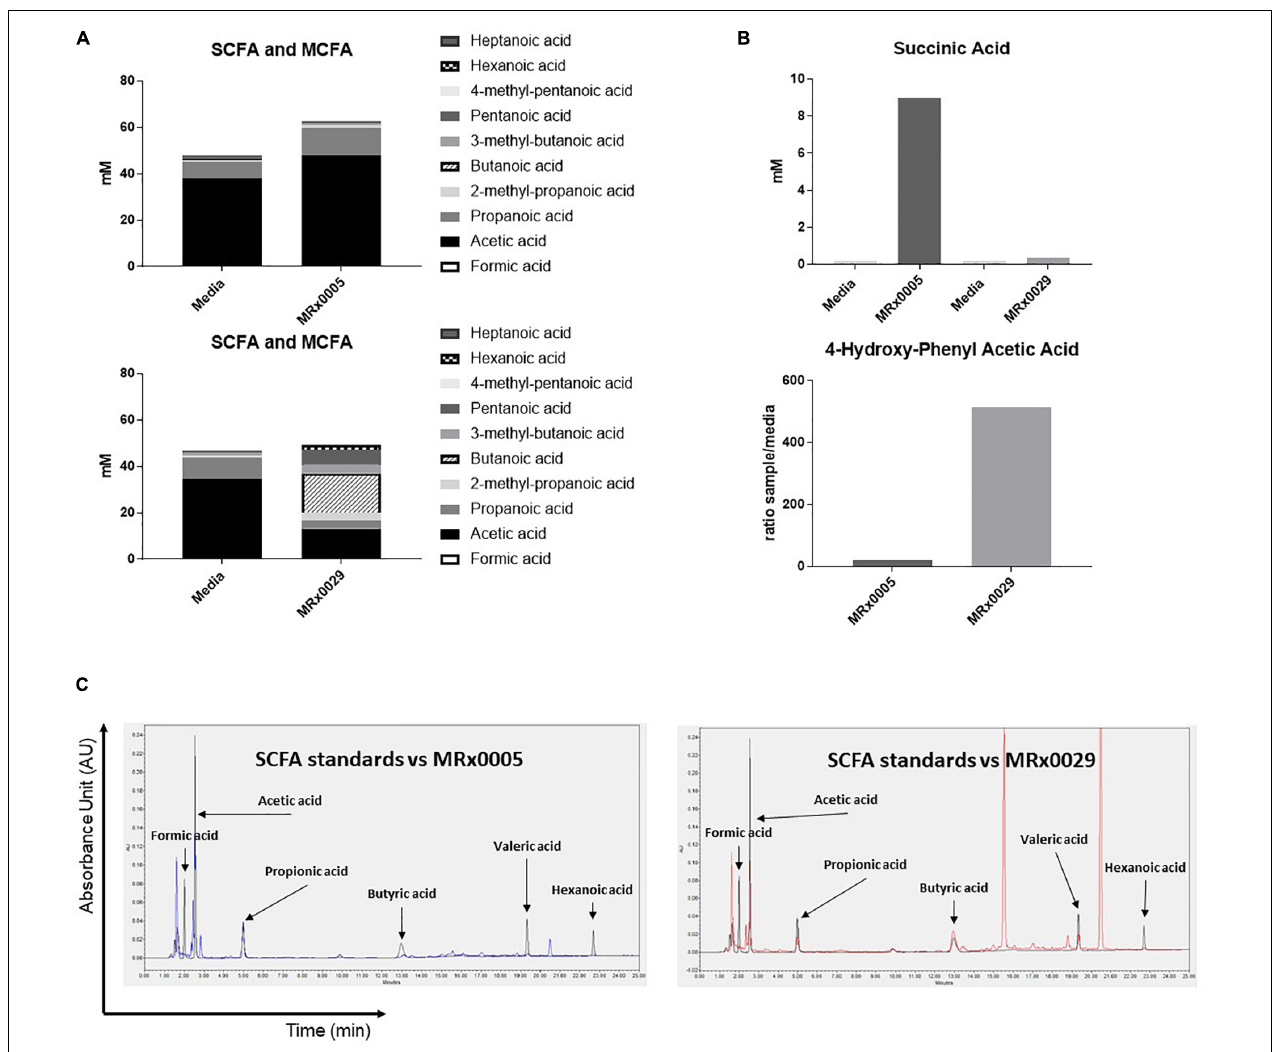
FIGURE 4 | Difference in metabolites produced by MRx0005 and MRx0029. Bacteria were grown to stationary phase and processed as described in section “Materials and Methods.” YCFA + was processed alongside MRx0005 and MRx0029. Authentic chemical standards were compared to retention time and mass spectra for the identified metabolites and/or based on library matching of the acquired MS spectra with the NIST library. Only metabolites that differed between the two strains are reported in this figure. (A) SCFA and MCFA profile (mM). (B) Succinic acid (mM) and 4-hydroxy-phenyl acetic acid (ratio sample/media). The data presented in (A,B) are from one experiment ( n = 1). (C) Representative chromatograms for MRx0005 (left panel in blue) and MRx0029 (right panel in red) overlaid to a standard mix of SCFAs and MCFAs (Formic acid 10 mM, Acetic acid 20 mM, Propionic acid 10 mM, Butyric acid 10 mM, Valeric acid 10 mM, and Hexanoic acid 10 mM in